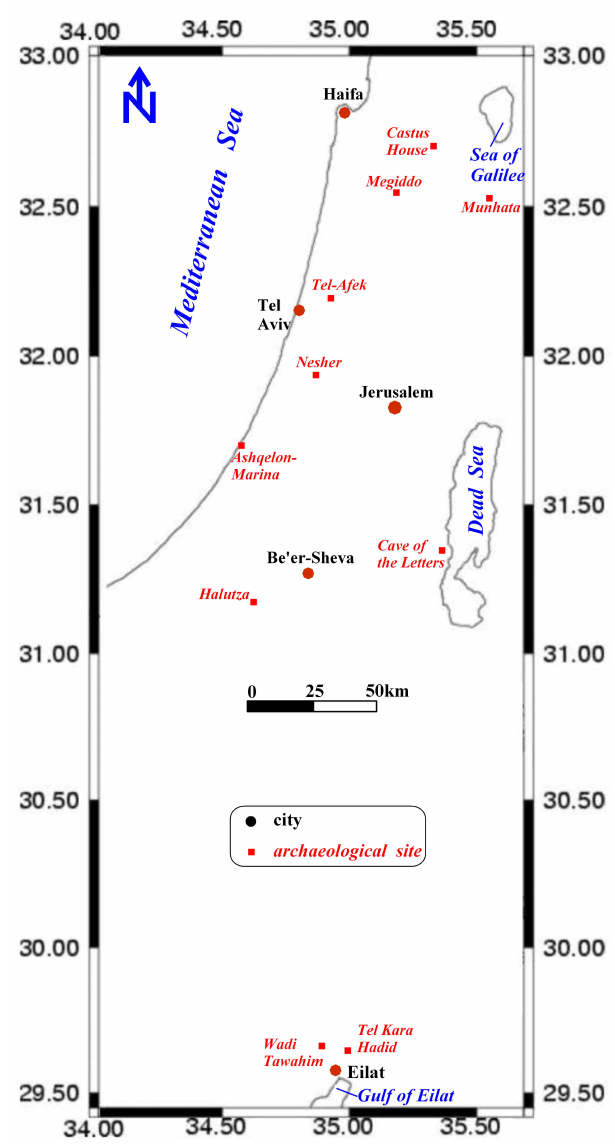
Fig. 1. Map of the area under study showing several sites mentioned in the